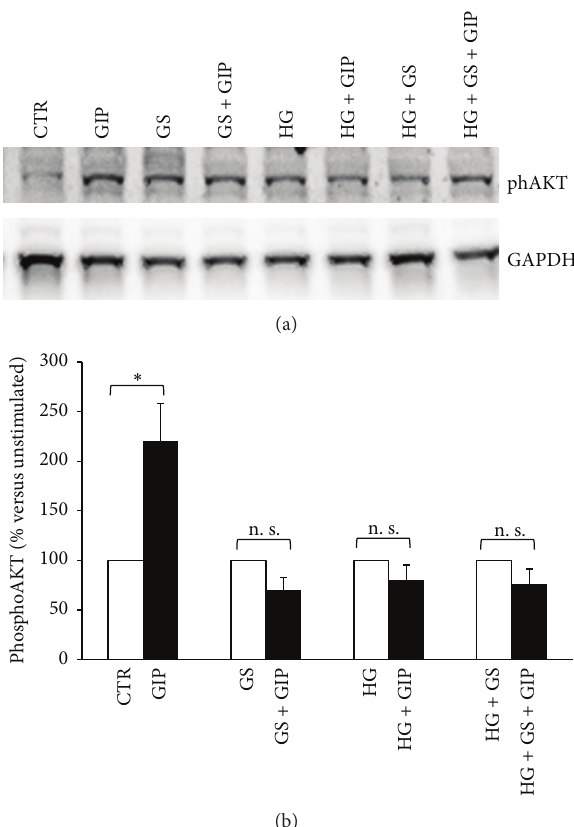
Figure 3: Treatment with GS abrogates GIP-induced phosphoryla- tion of AKT (Ser473) at both low and high glucose concentration. After 5-day treatment in the presence of standard medium (CTR) or high glucose concentration (11.1mmol/L) (HG) in presence of glycated serum (GS), HIT-T15 cells were incubated for 2 hours in serum-free medium and then stimulated with 100 nmol/L GIP for 5 min (dark bars). (a) Representative western blot analysis. (b) Quantification of densitometries of western blot bands. Data were expressedasmean ± SEoffoldinductionrelativetoGAPDH( 𝑛 = 3 ). ∗ 𝑃 < 0.05 versus absence of GIP; n. s.: nonsignificant.